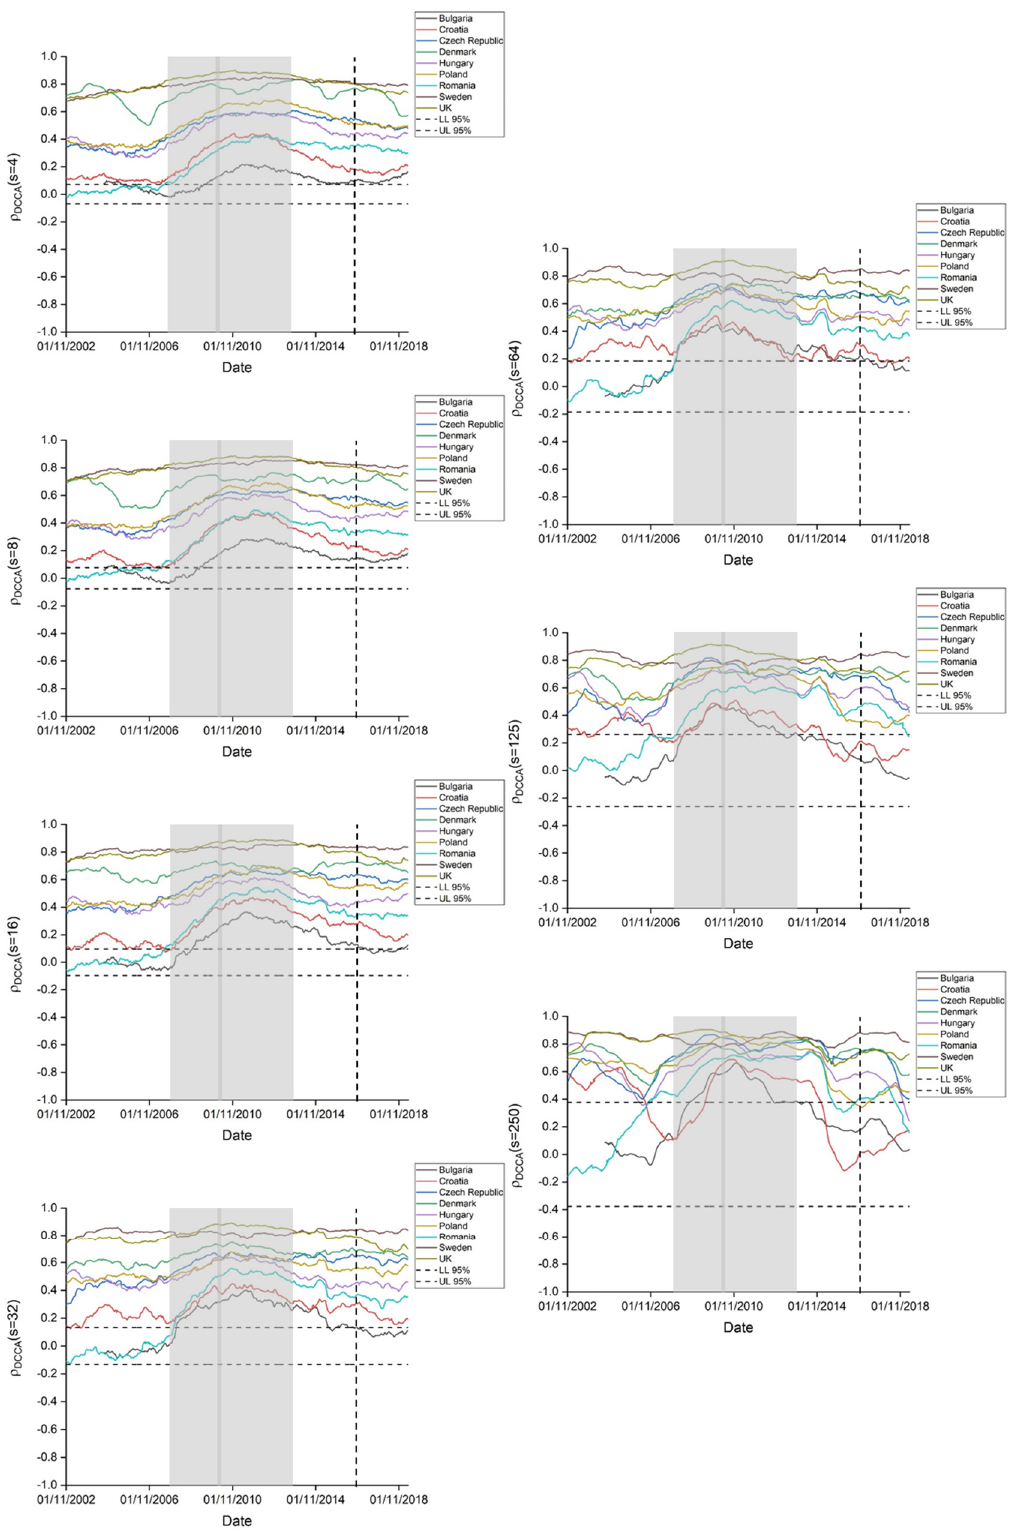
Figure A2. Evolution of ρ DCCA between non-Eurozone stock markets and Germany (time scales of 4, 8, 16, 32, 64, 125, and 250 days with a window size w = 1000). LL and UL are, respectively, the lower and upper limits of the confidence interval. Shaded areas represent the global financial crisis and the Eurozone debt crisis. The vertical dashed line refers to the moment of the Brexit referendum.